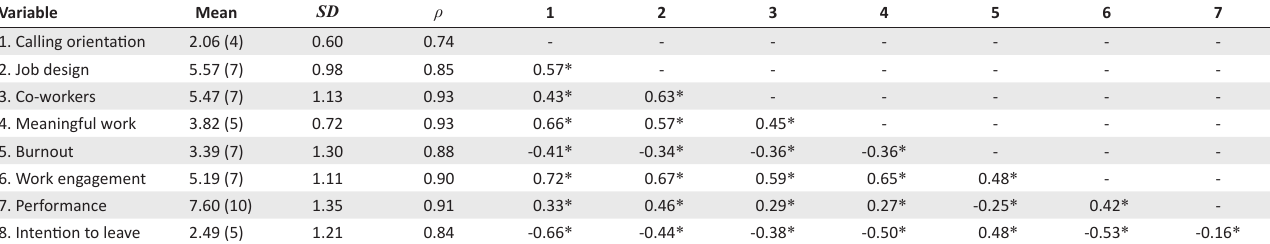
TABLE 3: Reliability coefficients and correlations of the scales ( N = 513). Variable